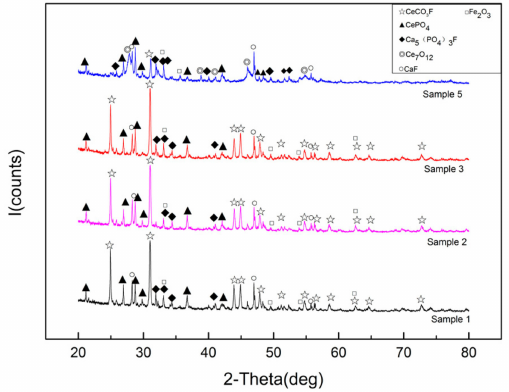
Figure 2. Analysis of rare earth concentrate ore phase subjected to di ff erent